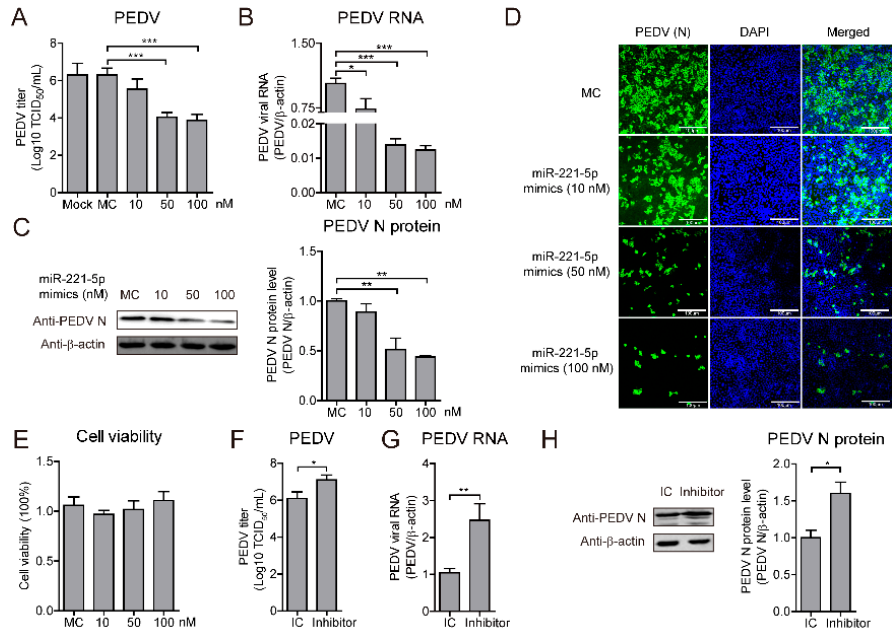
Figure 2. miR-221-5p inhibits PEDV replication in MARC-145 (African green monkey kidney epithelial cells). ( A – E ) MARC-145 cells were transfected with miR-221-5p mimics at different concentrations (10, 20, 50, and 100 nM) or mimic control (MC) for 24 h, followed by infection with CH/HBTS/2017 for an additional 24 h. ( A ) TCID 50 analysis of viral titers. Data represent the mean ± SD of three independent experiments and measured in technical triplicate. ( B ) Real-time qRT-PCR analysis of intracellular virus genomic RNA (normalized to β -actin expression). Data represent the mean ± SD of three independent experiments and measured in technical duplicate. ( C ) Immunoblot analysis of intracellular PEDV N protein levels. The intensity represents PEDV N protein level (top) normalized to that of β -actin across three independent experiments. ( D ) Immunofluorescence analysis of intracellular PEDV N protein levels. Scale bar = 100 µ m. ( E ) MTT assay to assess cell viability. Data represent the mean ± SD of three independent experiments and measured in technical triplicate. ( F – H ) MARC-145 cells were transfected with miR-221-5p inhibitors or IC at 50 nM for 12 h, followed by infection with CH/HBTS/2017 for an additional 36 h. ( F ) TCID 50 analysis of viral titers. Data represent the mean ± SD of three independent experiments and measured in technical triplicate. ( G ) Real-time qRT-PCR analysis of intracellular viral genomic RNA (normalized to β -actin expression). Data represent the mean ± SD of three independent experiments and measured in technical duplicate. ( H ) Immunoblot analysis of intracellular PEDV N protein levels. The intensity represents PEDV N protein level (top) normalized to that of β -actin across three independent experiments. Comparisons between groups were determined by Student’s t test. * p < 0.05; ** p < 0.01; *** p < 0.001.